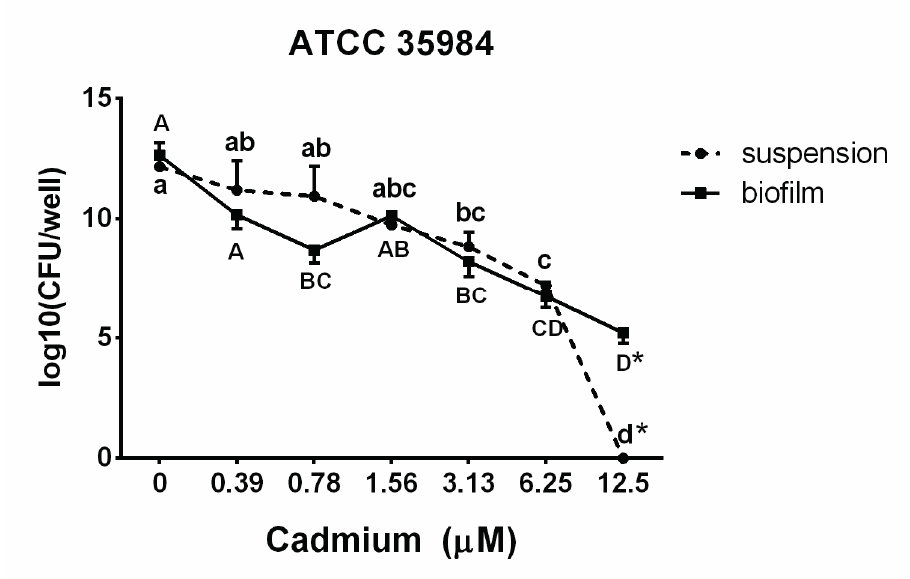
Figure 3. The bacterial population S. epidermidis (ATCC 35984) in suspension and biofilm after exposure to different concentrations (0.39–12.5 µM) of cadmium.